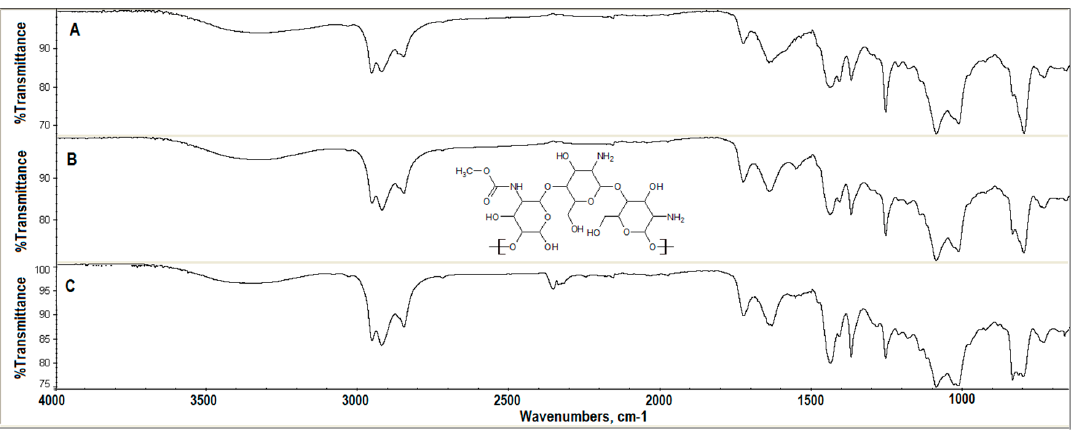
Figure 1 . FTIR spectra of the siliconized latex catheter recorded during a three-stage modification using SPA-M1 method: the untreated catheter ( A ), CHT-treated and GLU-activated catheter ( B ), SPA-treated catheter ( C ).